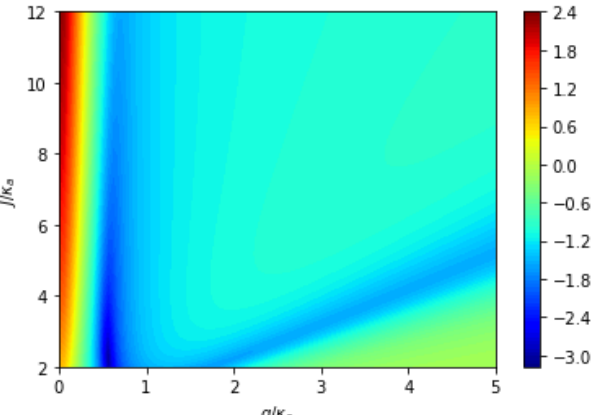
Figure 5. The equal-time second-order correlation function g ( 2 ) ( 0 ) as a function of the scaled coupling strength g / κ a and the scaled hopping interaction strength J / κ a under the resonant condition ∆ = ∆ a = ∆ = 0. Other parameters are the same as in Figure 4.